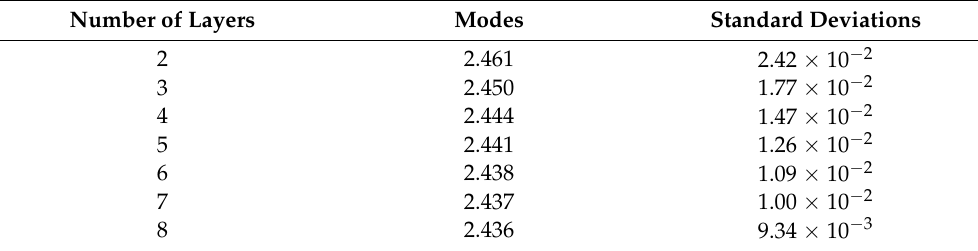
Table 5. Modes and standard deviations for the saturation density of 0.45 and the given number of layers.